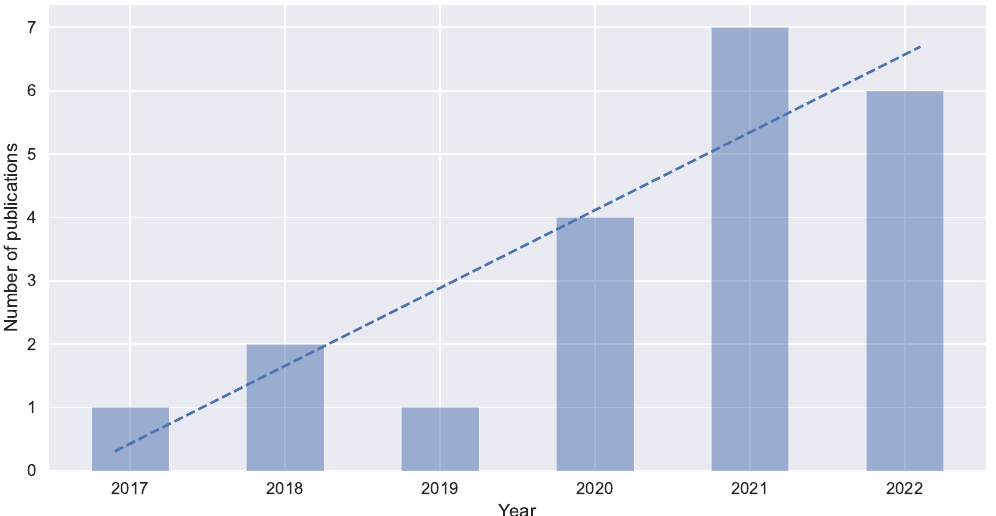
Figure 1. Number of works published each year between January 2017 and October 2022. The dashed line shows the trend, obtained with an ordinary least squares linear regression.